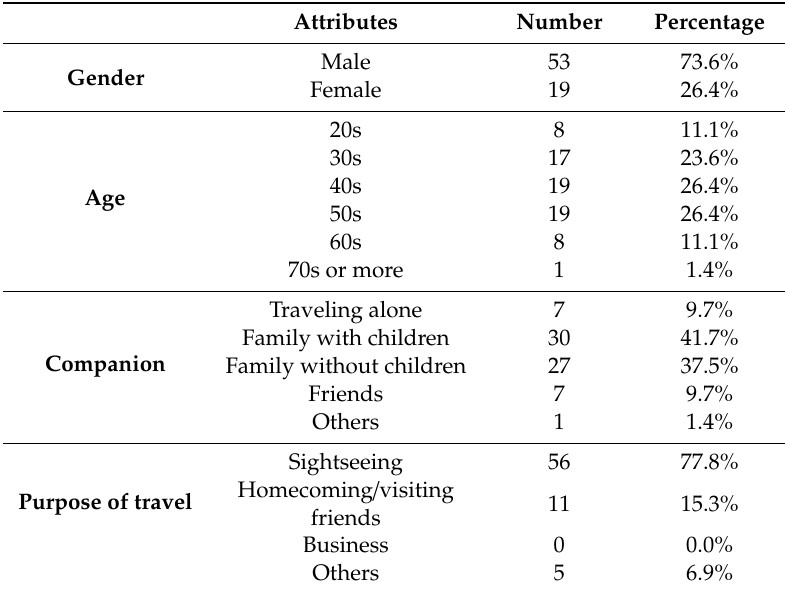
Table 1. Participant attributes overview.